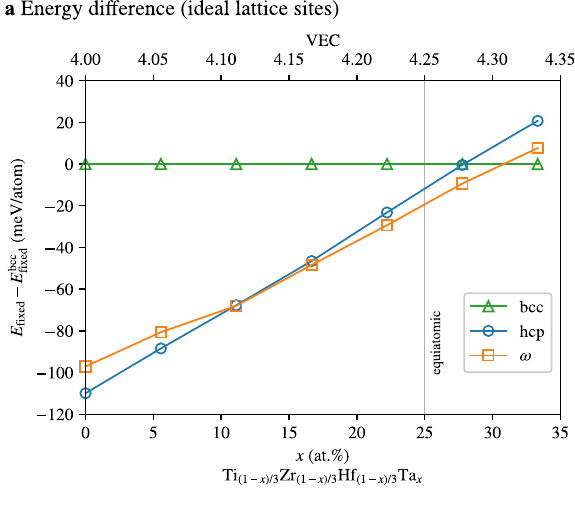
Fig. 7. TRIP behavior was observed for the composition of